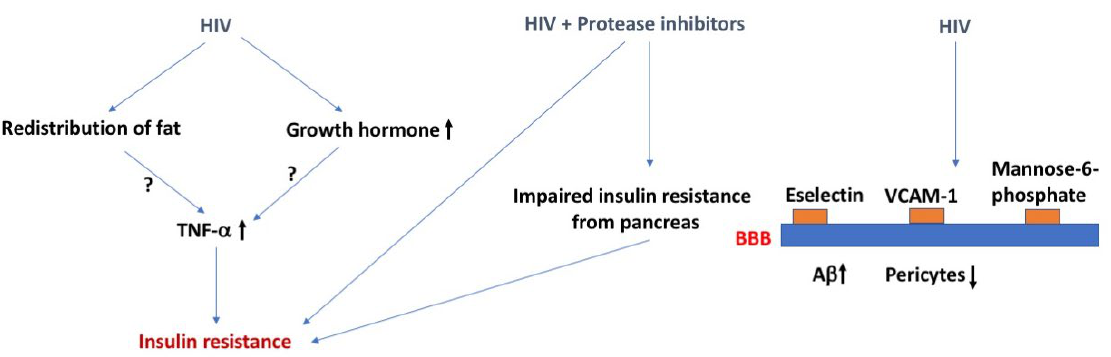
Figure 1. HIV, insulin resistance, and the BBB. The effects of HIV on insulin resistance might involve increases in TNF-a levels induced by redistribution of fat or enhanced growth hormone levels. HIV combined with the use of protease inhibitors as treatment can cause insulin resistance. Effects of HIV on the BBB might lead to an increase in brain A β levels and a decrease in pericytes. The arrows in bold indicate the direction of the effects. For more details, see text.